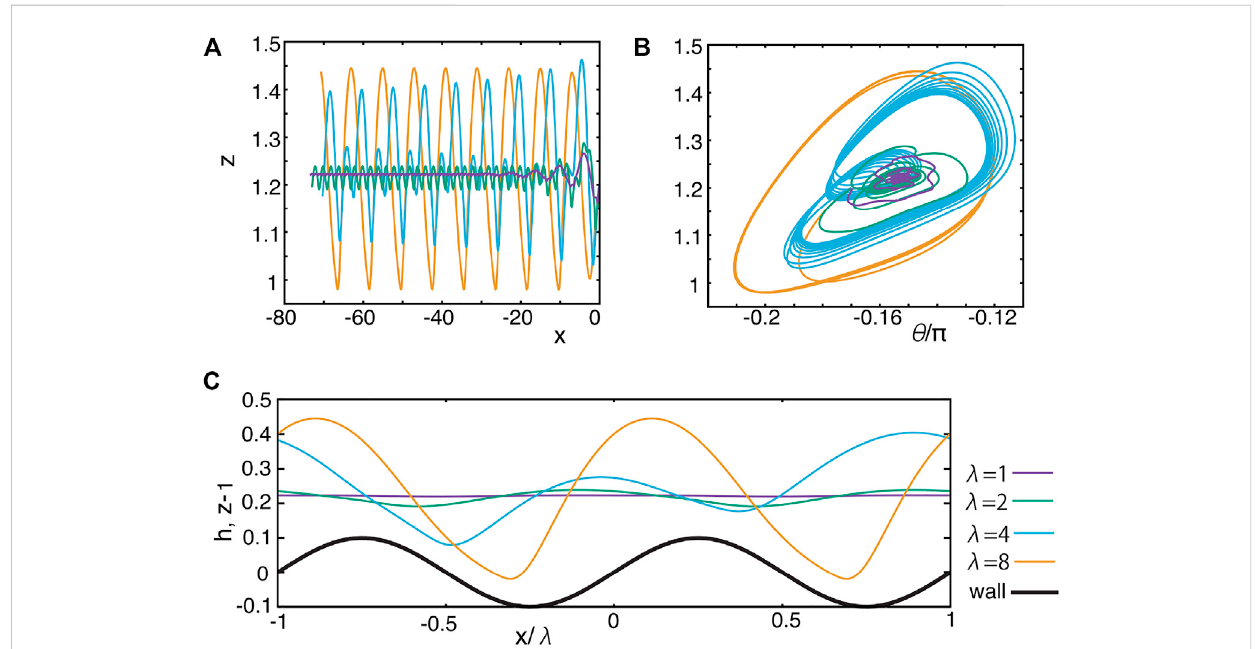
FIGURE 6 DynamicsofthesquirmerswimmingadjacenttothesinglyperiodicsinusoidaltopographyofEq.4andFigure2A,withdifferentwavelengths λ =1,2, 4, 8. The wave amplitude of the topography is fi xed at A = 0.1. (A) Trajectories in the x – z plane. (B) Trajectories in the θ – z phase plane. (C) Horizontally rescaled and shifted z position for the last part of the simulation (A) , together with the topography function h